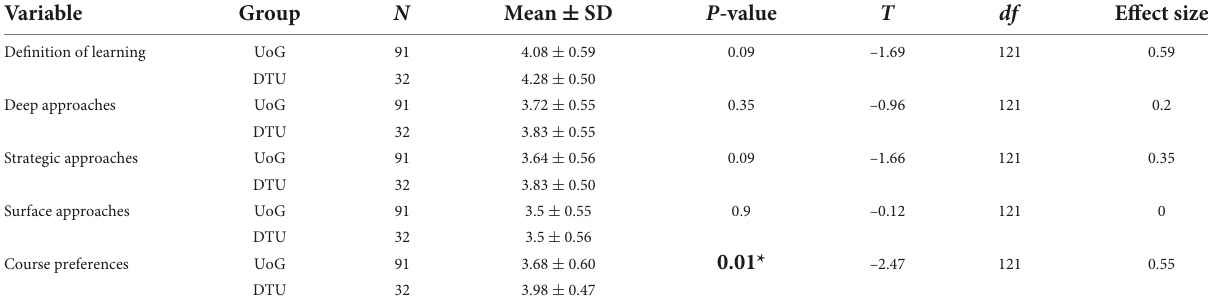
TABLE 2 Comparison of learning approaches of anesthesia students at Debre Tabor University (DTU) and University of Gondar (UoG), 2021. Variable Group N